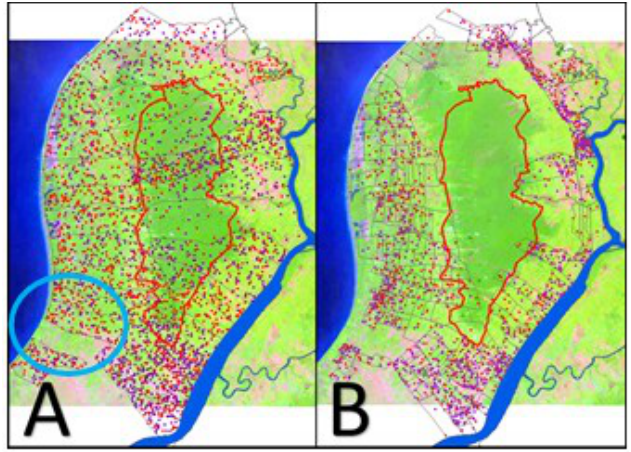
Fig. 14. Population density and Tax registration density visualized in village boundary base map (A) and RT boundary base map (B) Better visualization of population distribution pattern in a spatial extent can also be depicted from Figure 13. For instance, how population tends to disperse over villages on the west part of the area and tend to concentrate on the east side, can be apparently distinguished from Map B in Figure